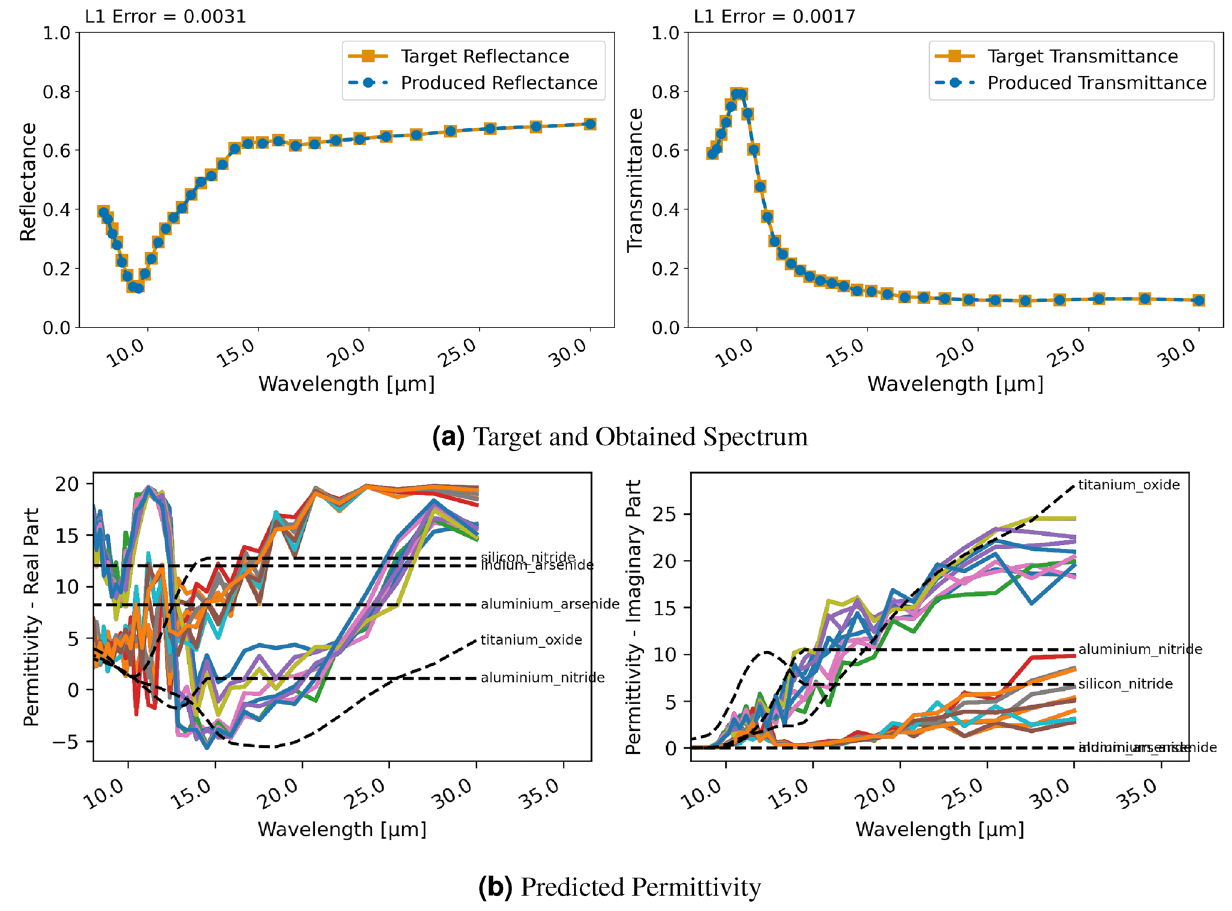
Figure 7. Inversion results for a two-layer patterned material using RCWA and regression; ( a ) displays target and produced spectra, ( b ) each line shows the utilized permittivity for a grid